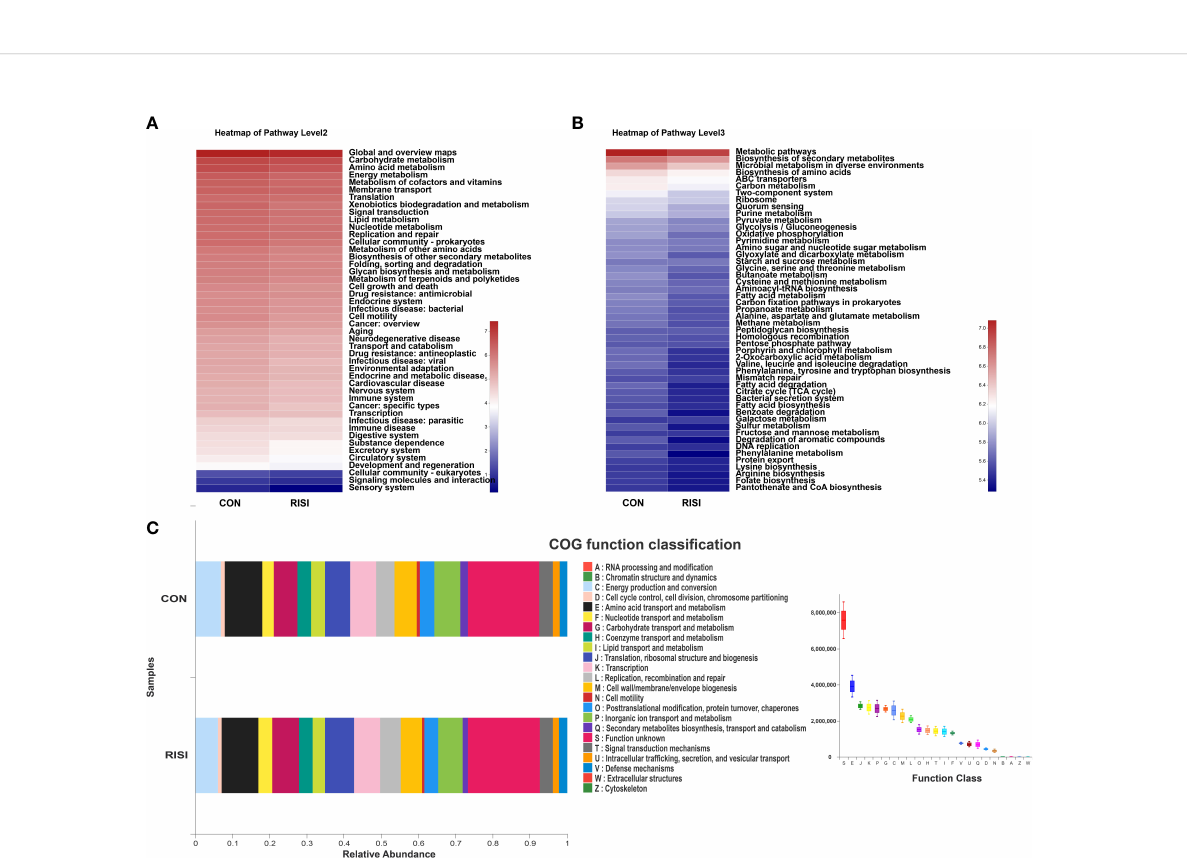
FIGURE 5 Differentially abundant metabolic pathways between radiation-induced skin injury (RISI) and healthy controls. (A) Kyoto Encyclopedia of Genes and Genomes (KEGG) pathways at level 2. (B) KEGG pathways at level 3. (C) Clusters of Orthologous Genes (COG) function.